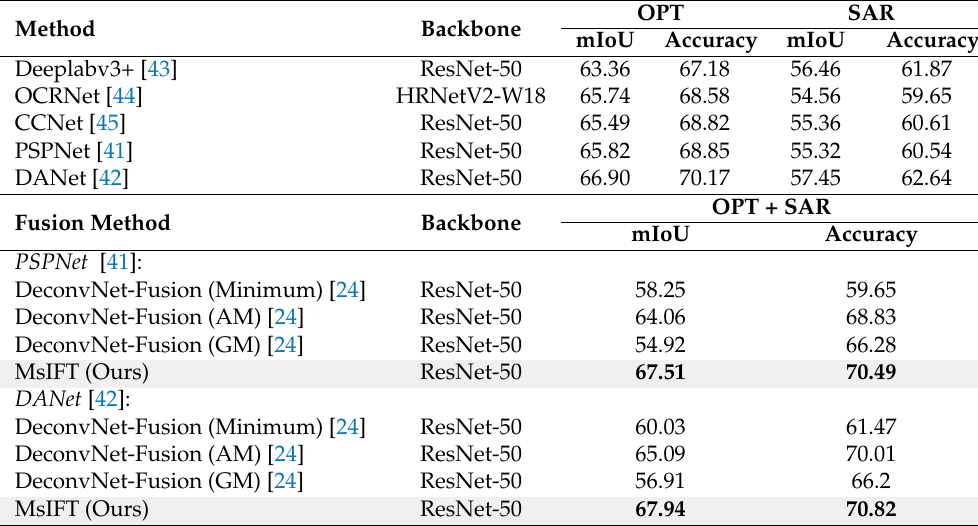
Table 6. Performance comparison on